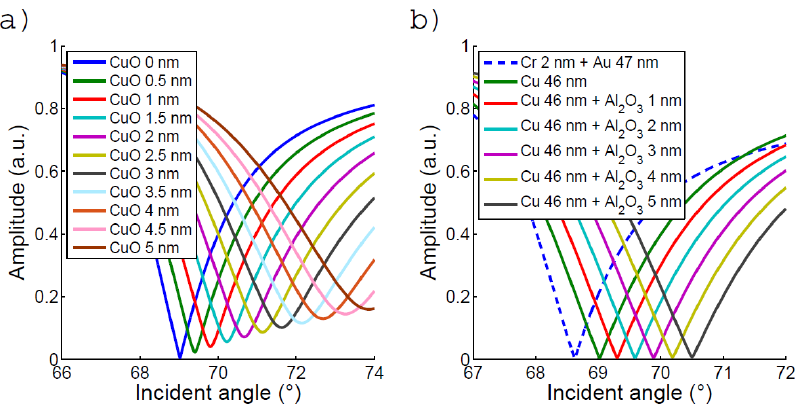
Figure 8. Simulation realized at 680 nm using the Fresnel coefficient for p-polarized light. ( a ) Simulation of an oxidized Cu 46 nm surface, for each 1 nm of CuO there is 0.563 nm of Cu removed. ( b ) Simulation of a 46 nm Cu surface passivated with different Al 2 O 3 thickness. A simulation of a 47 nm Au surface with 2 nm of Cr adhesion layer is presented as a matter of comparison. The copper oxide growth in Figure 4b is interpolated from the position of the resonance given in this figure.